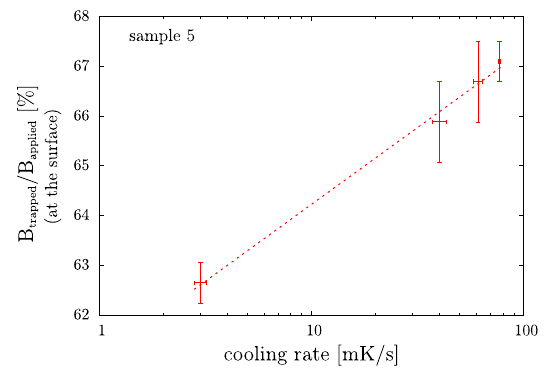
FIG. 6. Dependence of the trapped field on the cooling rate for a single crystal sample with 800 (cid:1) C tempering.